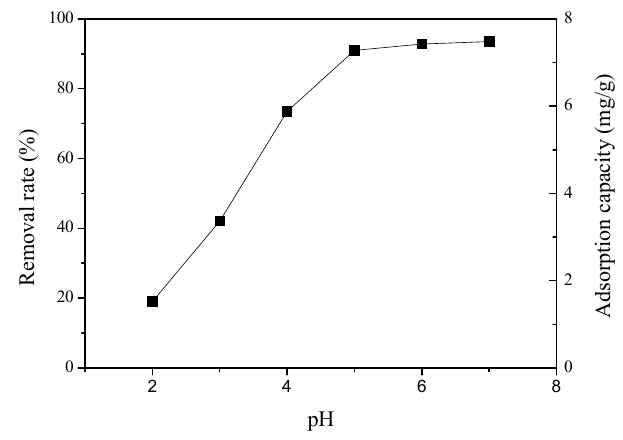
Figure 6. Effect of pH on the adsorption of Ni 2+ by synthesized zeolite (contact time 30 min, adsorbent dose 2.5 g/L, initial Ni 2+ concentration 20 mg/L).